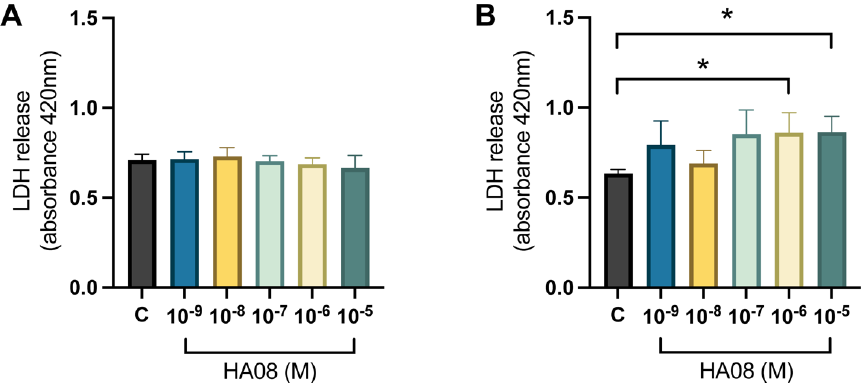
Figure 8. The effect of HA08 on membrane integrity. The results of the LDH release for ( A ) hippo- campal cells and ( B ) cortical cells after HA08 treatment. The control cells (C) were treated with 1 × 10 − 4 M hydrogen peroxide from days 8–9 and 0.1% DMSO from days 9–10. The remaining